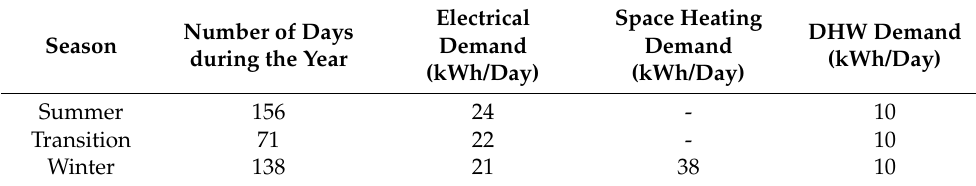
Table 3. The daily electrical and thermal energy demands for the single-family house during summer, winter, and transition seasons. Abbreviations: domestic hot water